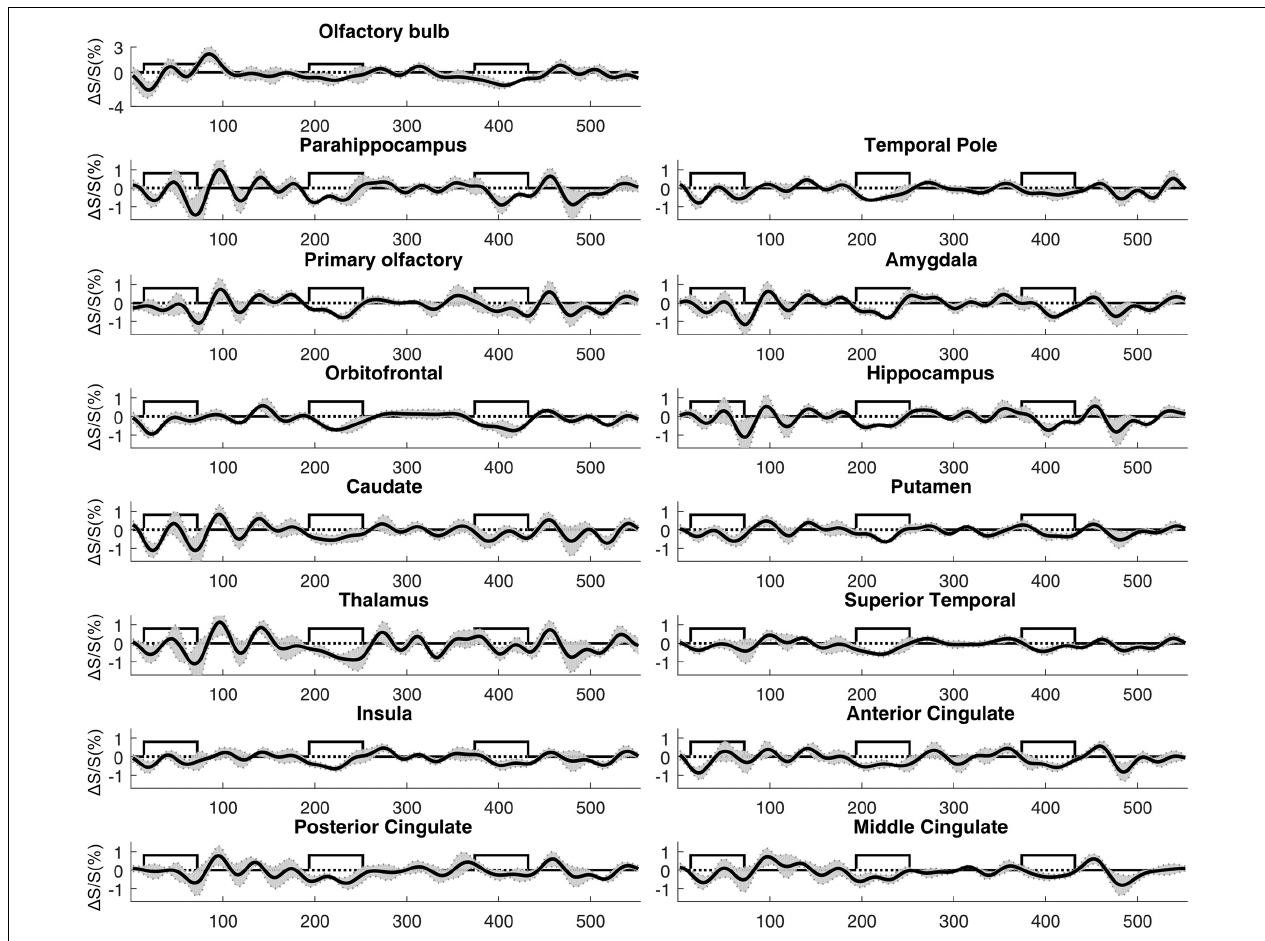
FIGURE 7 | Average time courses of fMRI signal changes from all participants ( n = 14). For each participant, the time course was averaged over negatively activated voxels in each ROI. The gray shaded area indicates the inter-subject standard error. The boxcar curve illustrates the timing of the olfactory paradigm described in Figure 1 . The order of the ROIs was arranged to be identical to Figure 6